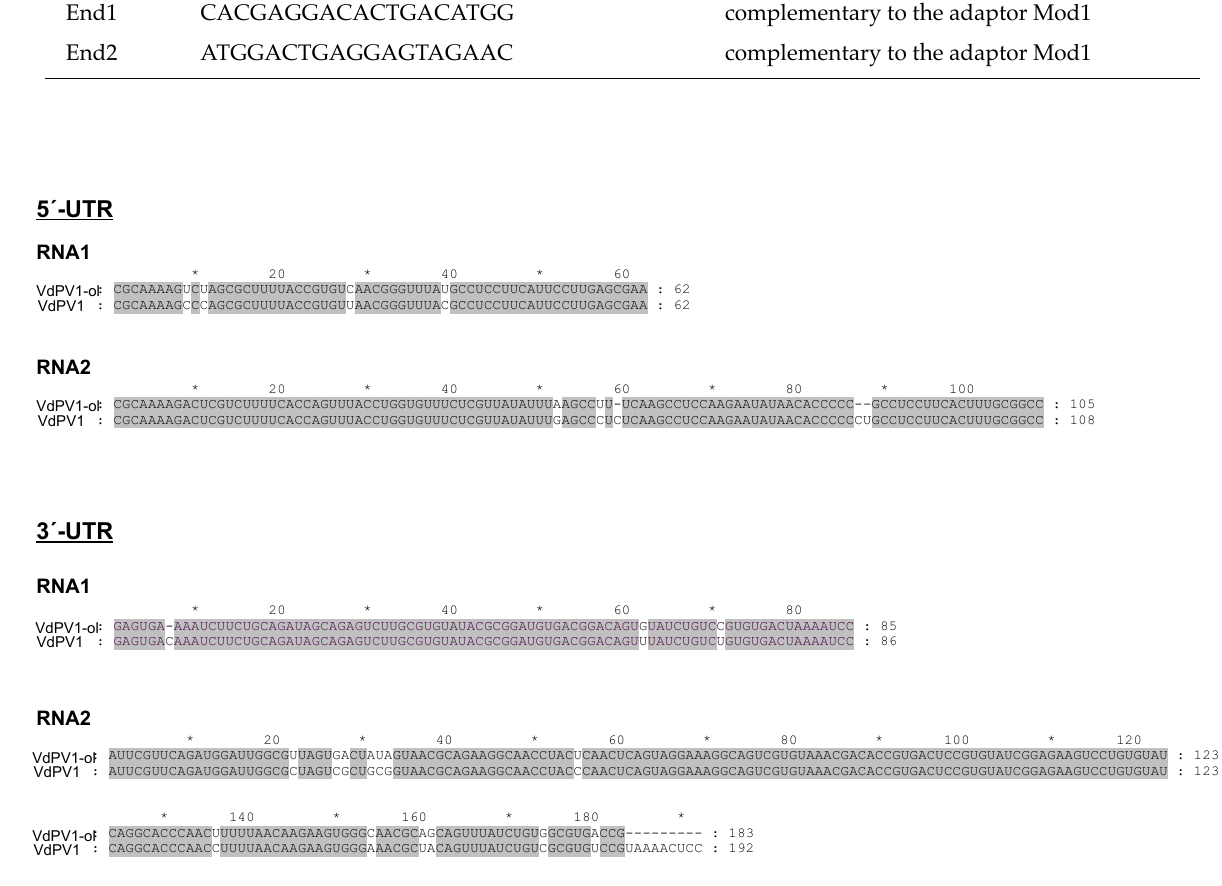
Supplementary Figure 1. Sequence alignment of the 5´- and 3´-untranslated regions (UTRs) of the coding strands of RNA1 and RNA2 of VdPV1-ol and VdPV1. Gray shading is used to highlight conserved residues in the aligned